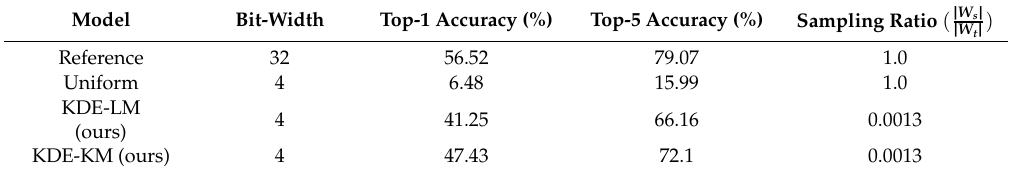
Table 1. Performance comparison of AlexNet architecture.